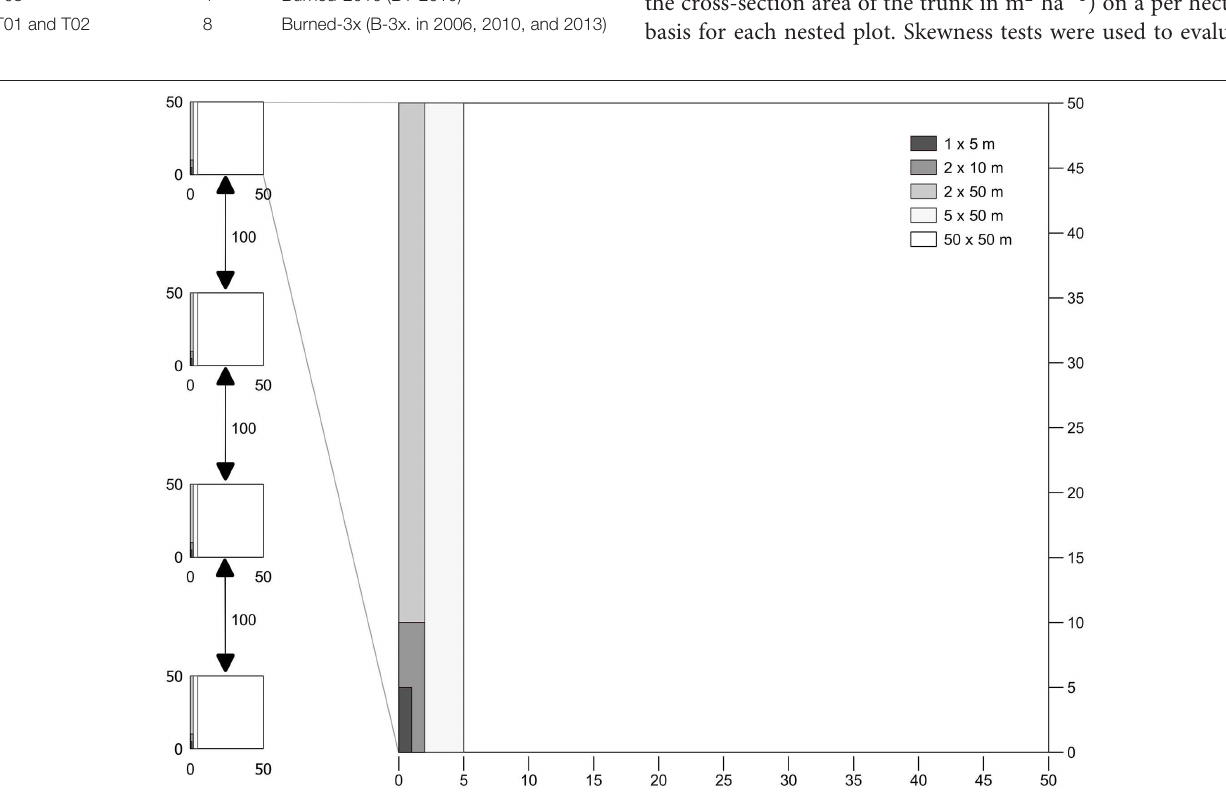
Frontiers in Forests and Global Change |